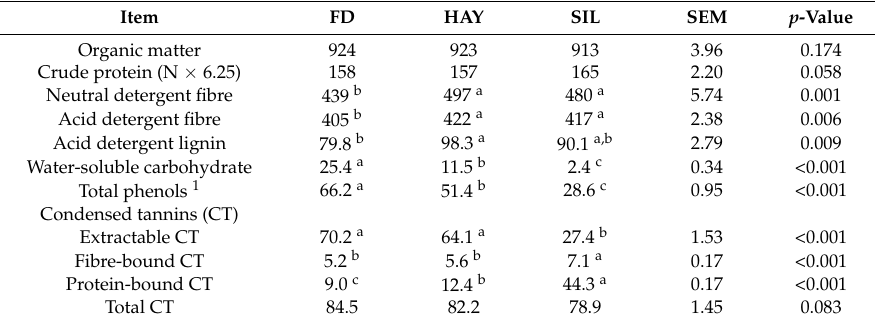
Table 1. Chemical composition (g/kg DM) of whole-plant purple prairie clover conserved as freeze-dried forage (FD), hay (HAY) or silage (SIL) ( n =